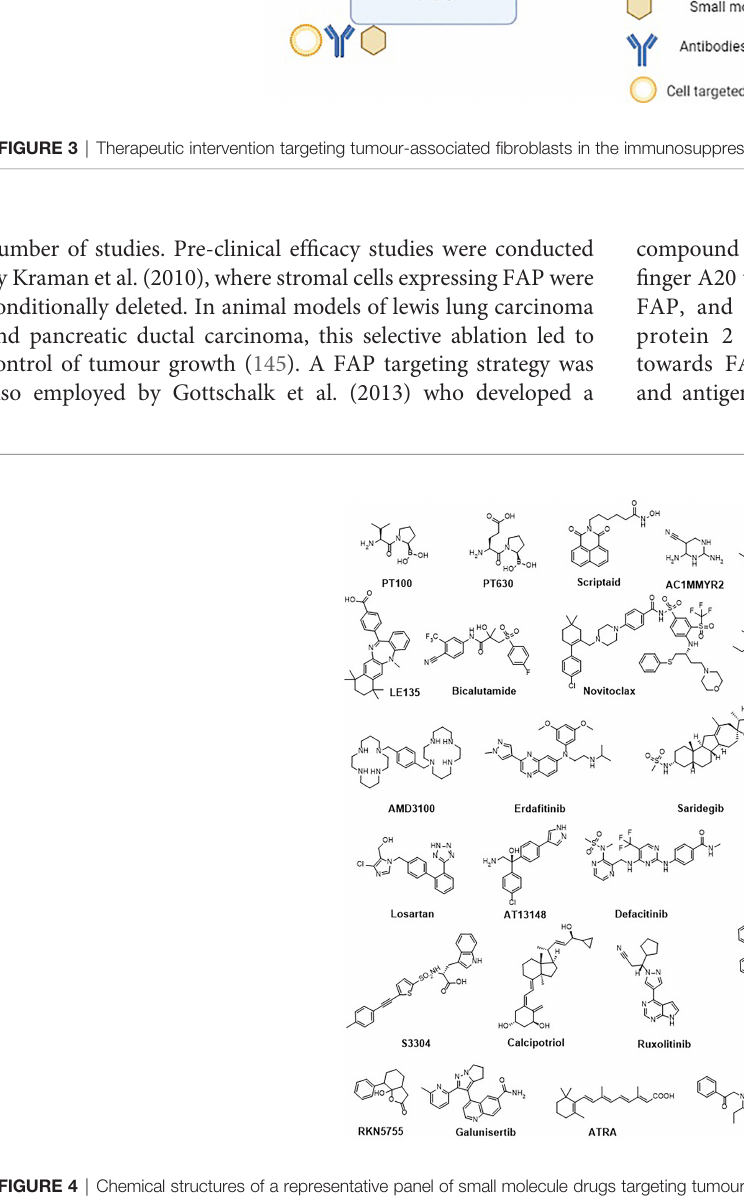
FIGURE 4 | Chemical structures of a representative panel of small molecule drugs targeting tumour-associated fi